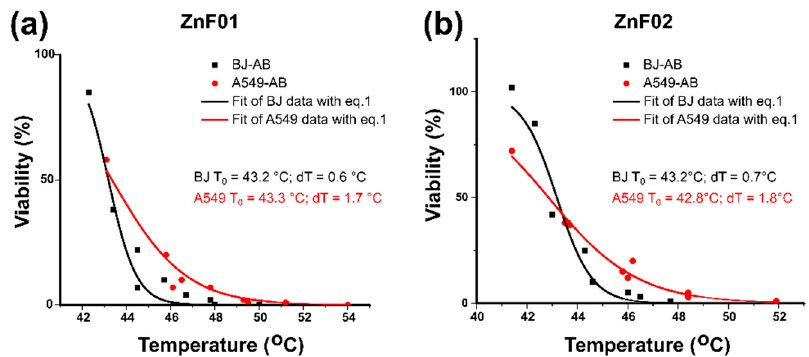
Figure 12. Viability data for BJ and A549 cell lines for ZnF01 ( a ) and ZnF02 ( b ) based on the AB assay, plotted against the saturation temperatures reached during MH and their corresponding fitting curves and fitting parameters based on equation 1.